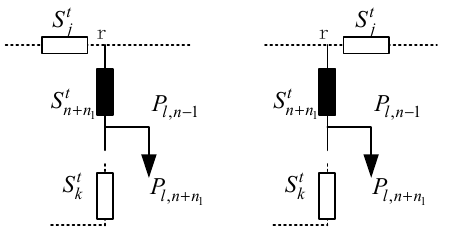
Figure 4. T-type series supply disconnect switch position.